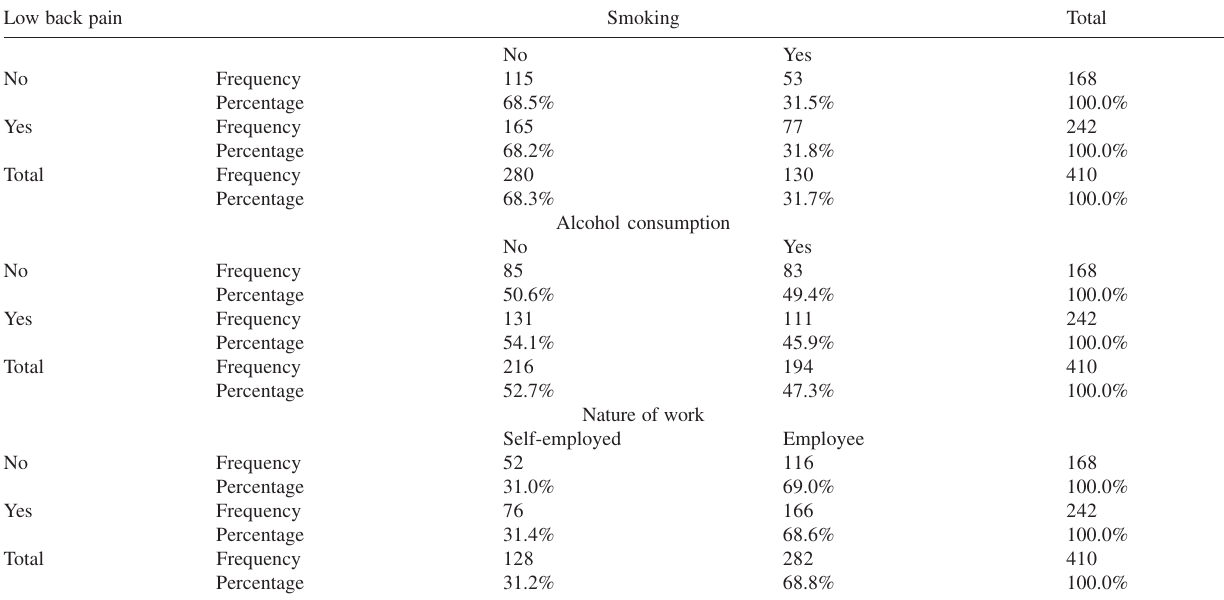
Table 3 - Frequency distribution and percentages of smoking, alcohol consumption, and nature of work variables according to the Yes and No categories of low back